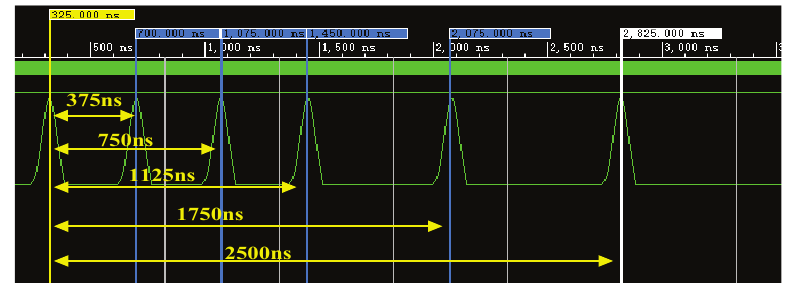
Figure 4. Hardware simulation of delay